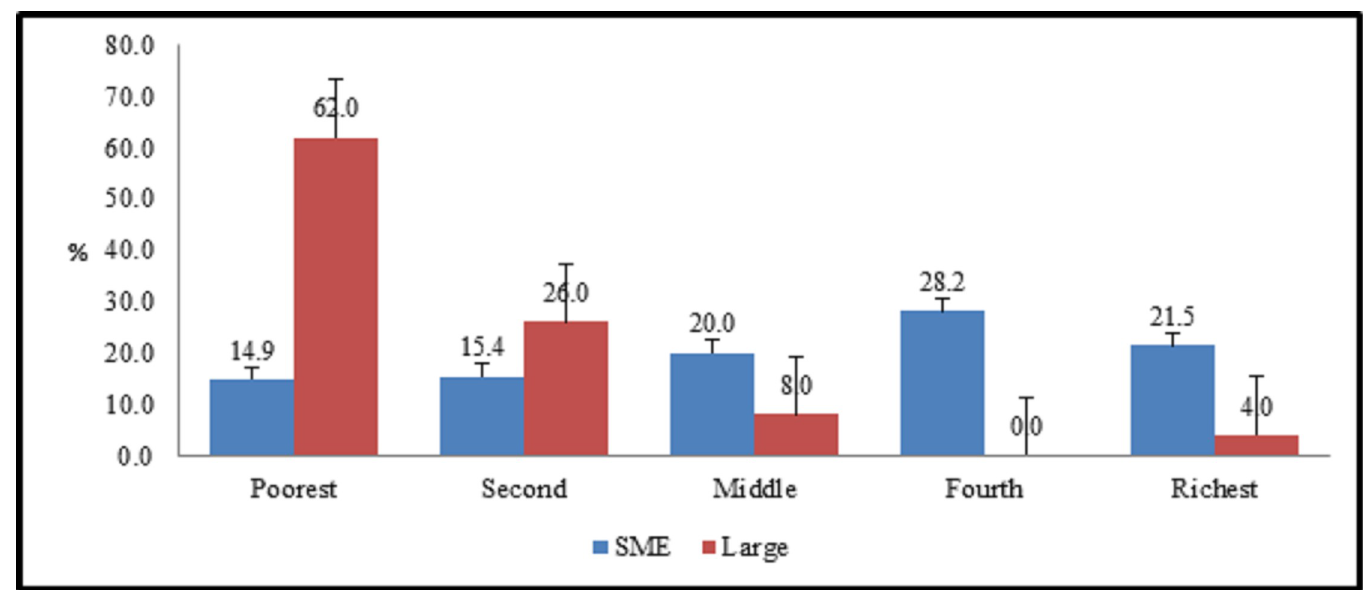
Fig 1. Type of industry and socioeconomic.